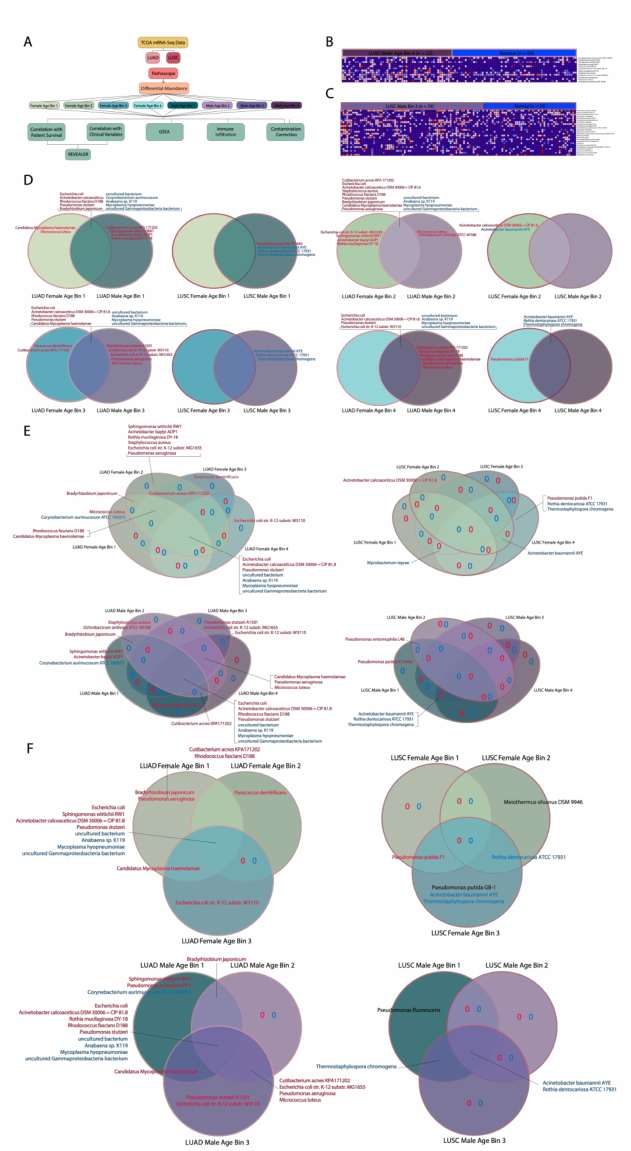
Figure 1. Summary of di ff erential abundance and patient cohort comparison results. ( A ) Schematic of study workflow. ( B ) Heat map comparing the lung adenocarcinoma (LUAD) Male Age Bin 4 cohort to adjacent normal samples. ( C ) Heat map comparing the lung squamous cell carcinoma (LUSC) Male Age Bin 3 cohort to corresponding adjacent normal samples. ( D ) Two-way Venn Diagram comparing the microbes in female and male cohorts within one cancer. Microbes written with red text represent upregulated microbes, whereas microbes written with blue text represent downregulated microbes when comparing cancer cohorts to normal samples. ( E ) Four-way Venn Diagram comparing the microbes associated with each age bin for each gender. Only microbes di ff erentially abundant in LUSC or LUAD samples vs. normal samples are included (Kruskal–Wallis test, p < 0.05). Microbes written with red text represent upregulated microbes, whereas microbes written with blue text represent downregulated microbes when comparing cancer cohorts to normal samples. ( F ) Three-way Venn Diagram comparing the microbes associated with each age bin for each gender. Only microbes di ff erentially abundant in LUSC or LUAD samples vs. normal samples are included (Kruskal–Wallis test, p < 0.05). Microbes written with red text or blue text represent upregulated and downregulated microbes, respectively, when comparing cancer cohorts to normal samples. Red or blue text also indicates that these microbes are also found in the four-way Venn diagram, while black text indicates that these microbes could not be located in the four-way Venn